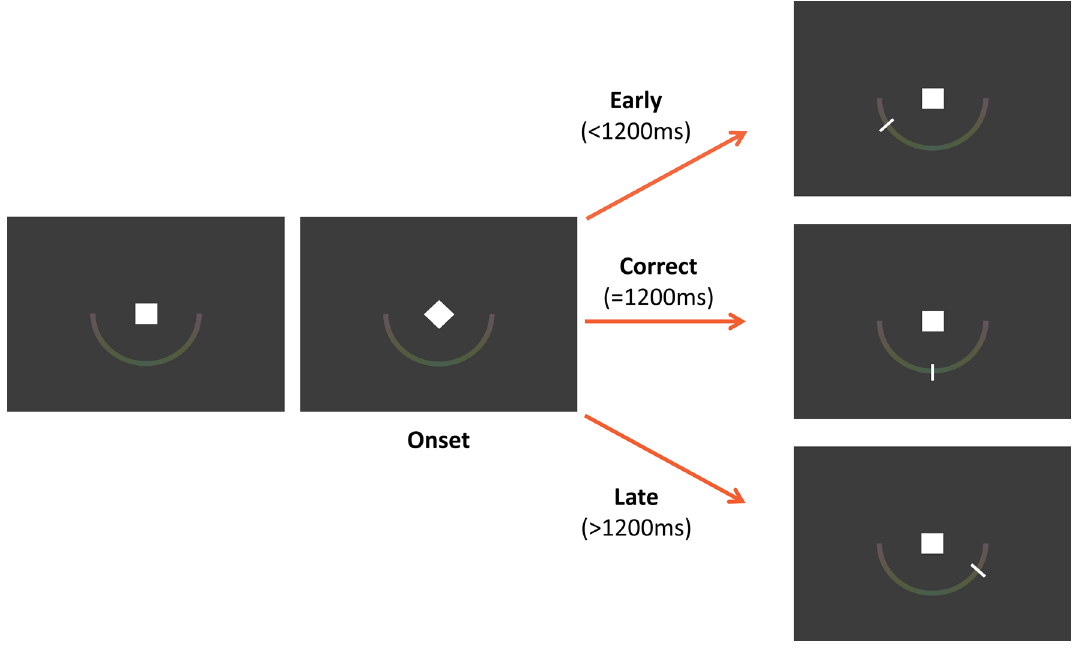
Figure 1. Time estimation (TE) task. Participants were asked to press a button 1200 ms after a start signal (rotation of a white square), with feedback on performance accuracy given on a continuous scale immediately after the button